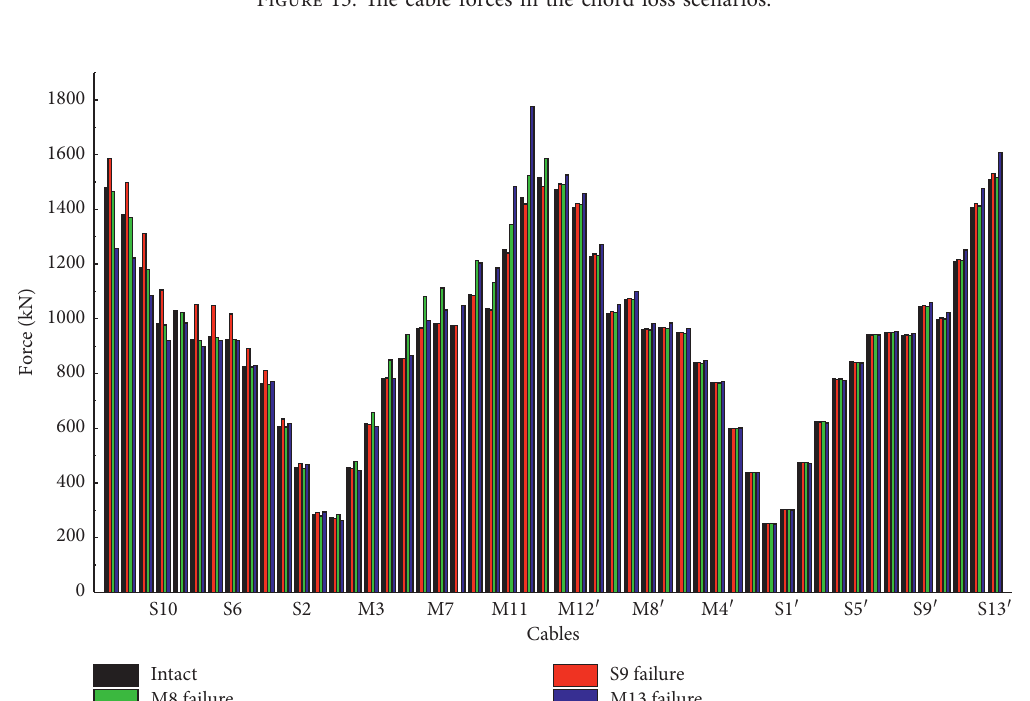
Figure 13: The cable forces in the chord loss